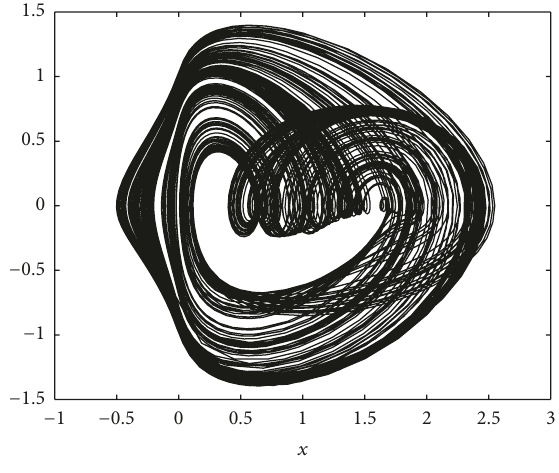
Figure 2: Phase diagram for 𝑤 = 0.6 .